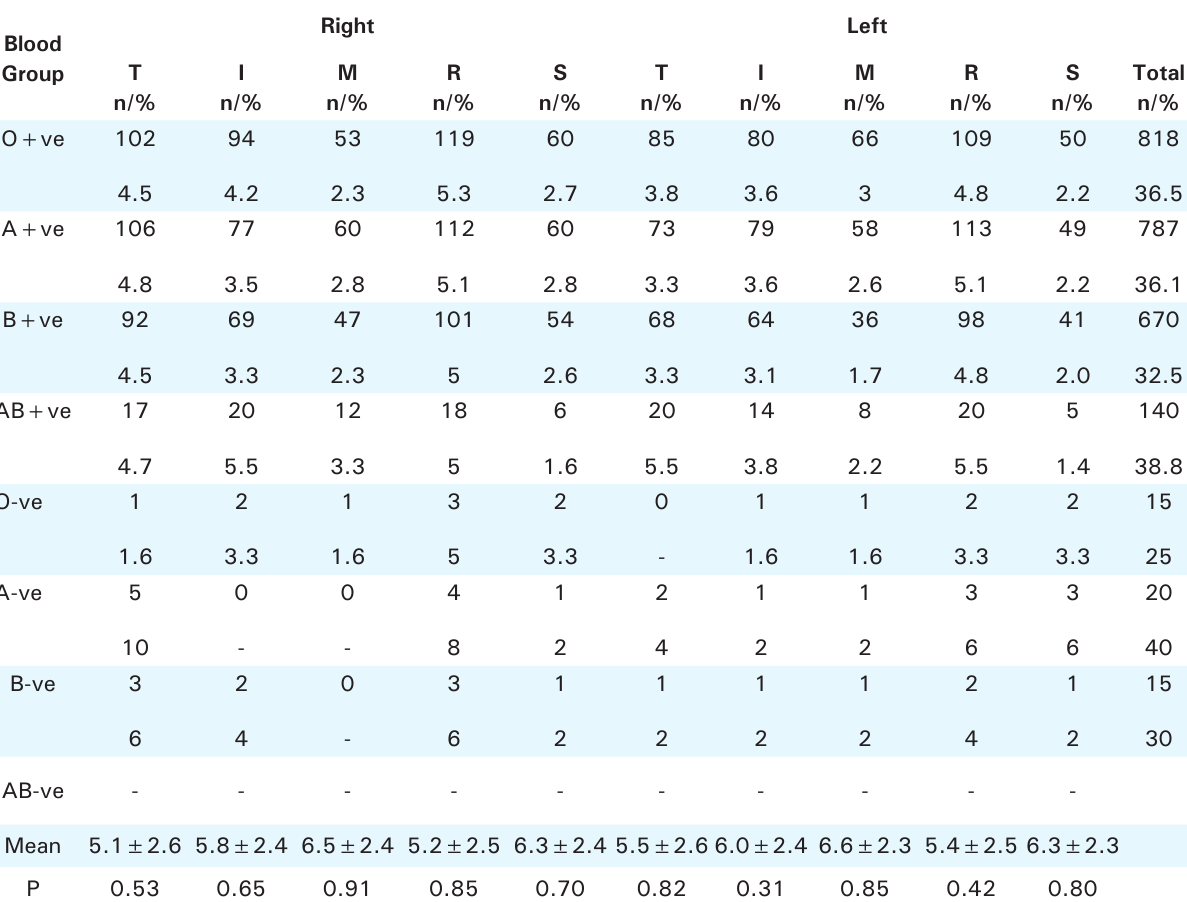
Table 4. Whorl distribution and its mean comparison in individual fingers with the blood groups. Right Left Blood T Group n/% n/%